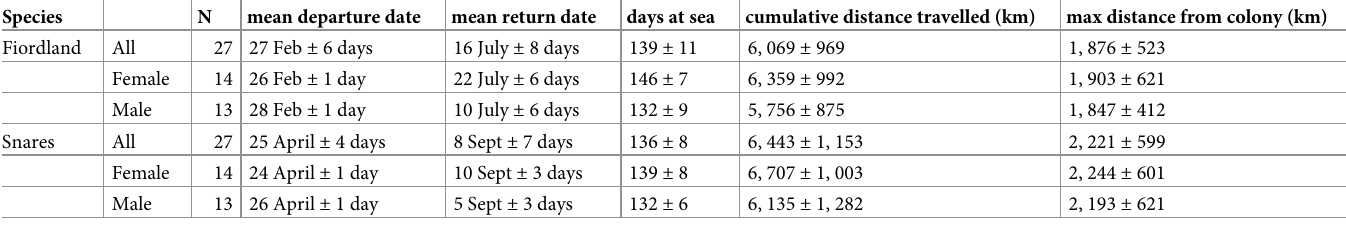
N denotes sample